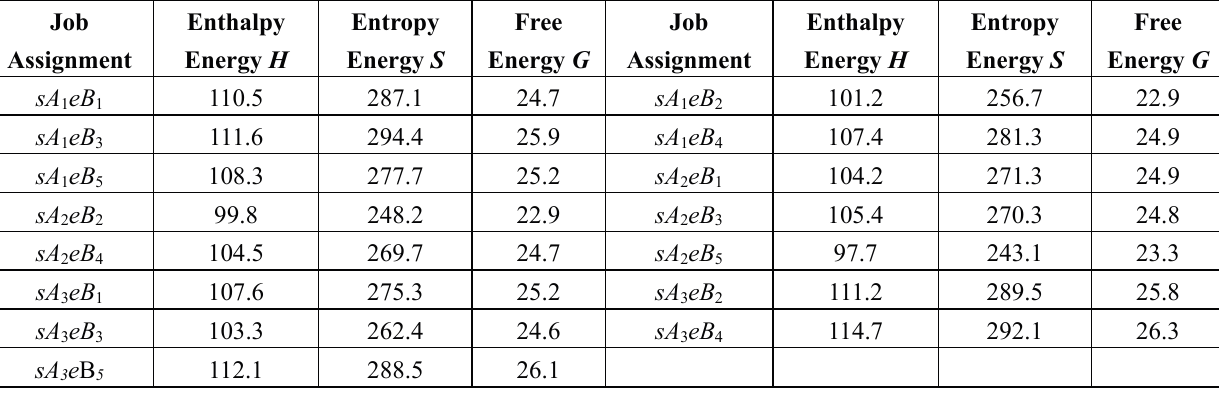
Table 10. The energies for of binding each probe to its corresponding region on a library strand.